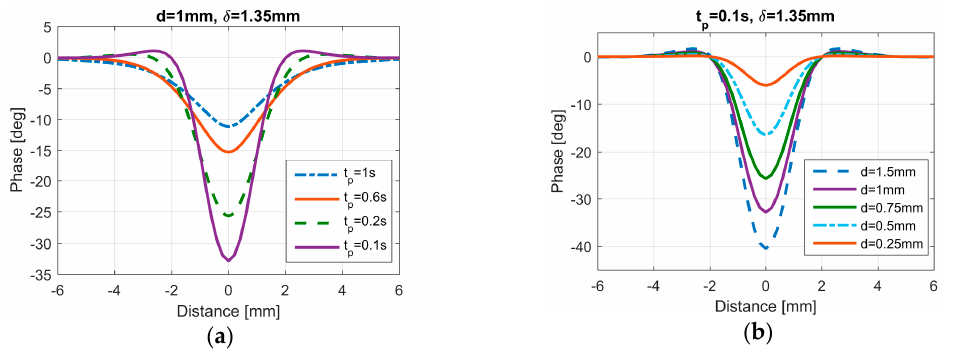
Figure 22. ( a ) Phase distribution for different heating pulses for the same crack ( d = 1 mm, δ = 1.35 mm); ( b ) phase for different crack depths after a 0.1 s heating pulse.